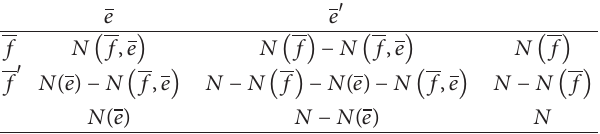
Table 1: Contingency